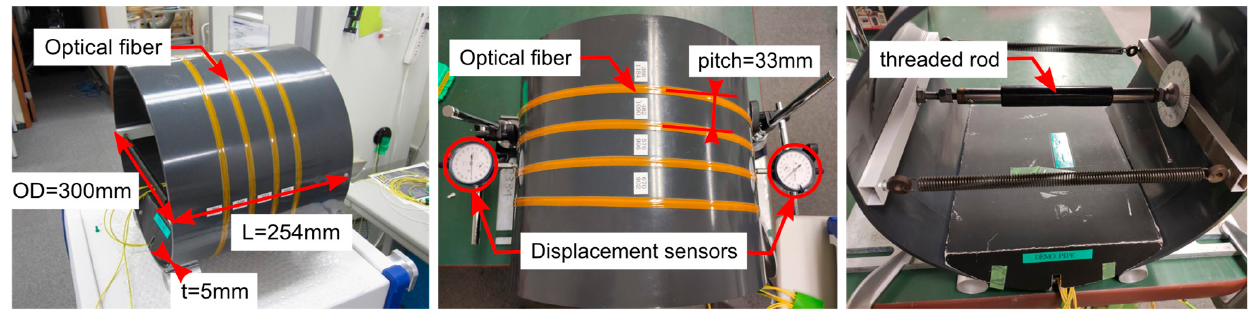
Figure 6. Schematics of experiment setup.